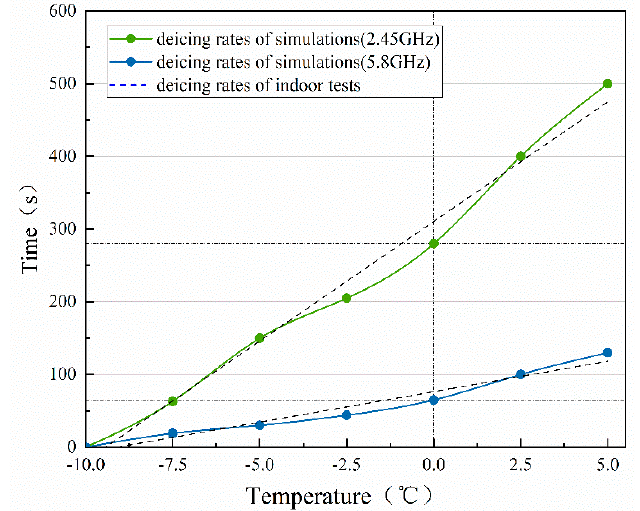
Figure 9. Comparison of deicing rates between indoor tests and simulations of different frequencies.